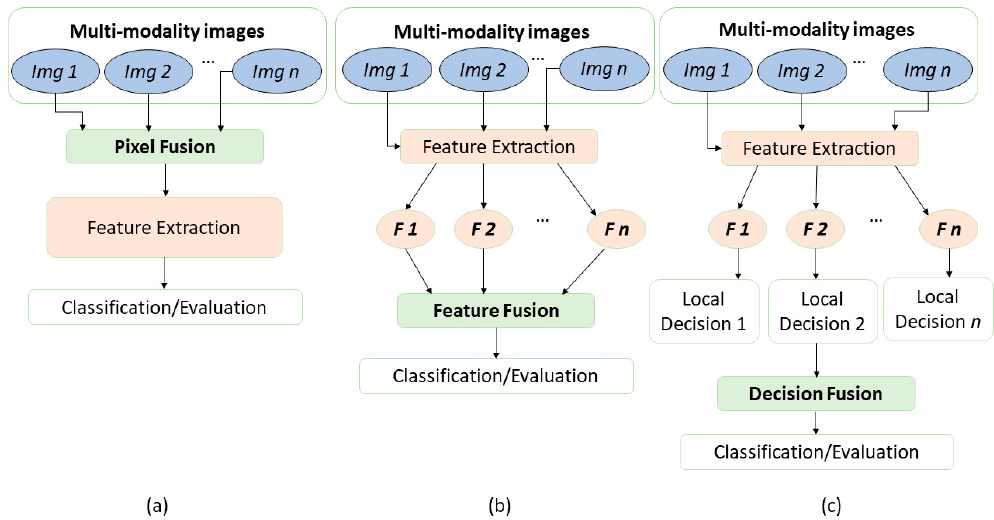
Figure 1. An overview of image fusion levels. The diagram describes three levels of data fusion to classify or evaluate the extracted information of combined images. ( a ) represents pixel-level fusion, ( b ) represents the feature-level fusion, and ( c ) corresponds to decision-level fusion. All data fusion schemes aim to use the information from all modalities to make the decision more accurate than the decision achieved with a single modality alone. Adapted with permission from reference [3], 2021, Elsevier.